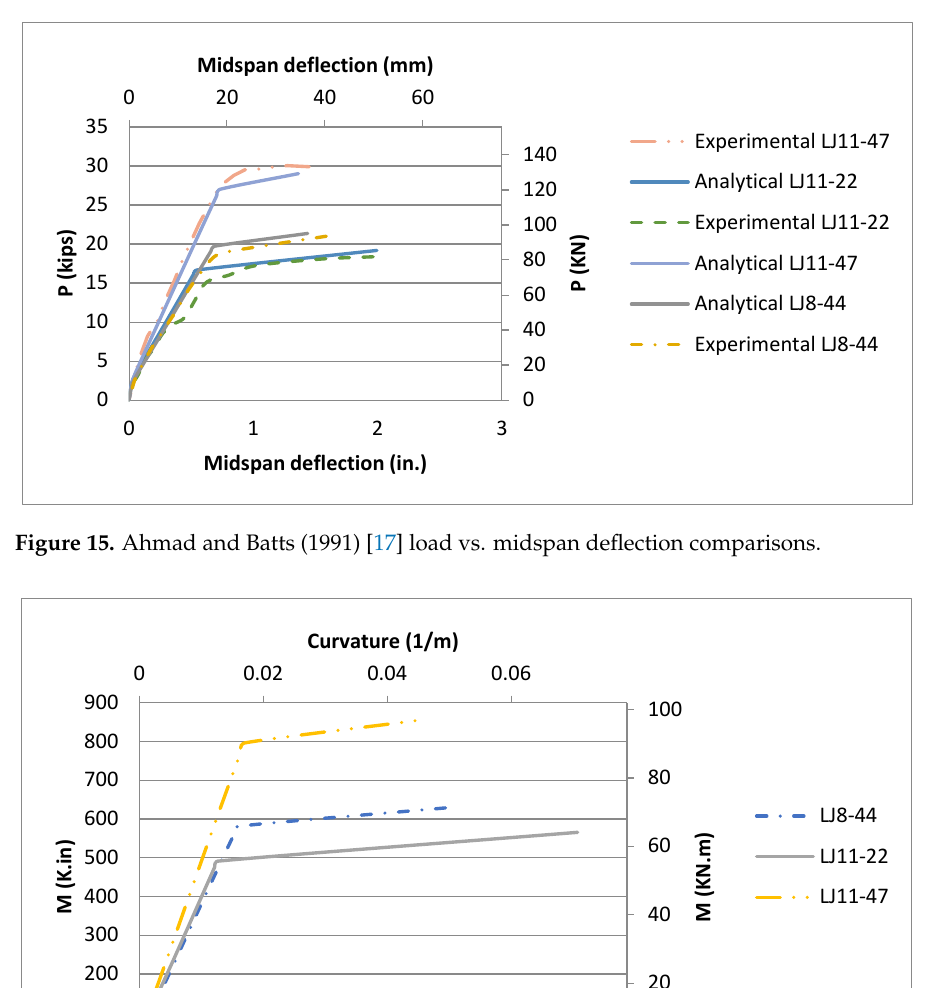
Figure 14. Ahmad and Barker (1991) [16] moment vs. maximum compressive strain analytical graphs.